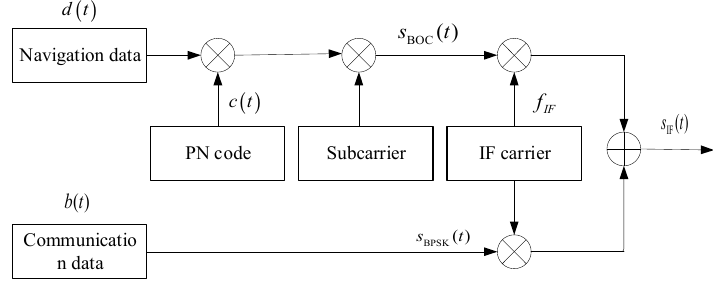
Figure 1. The transmitter of the composite signal.